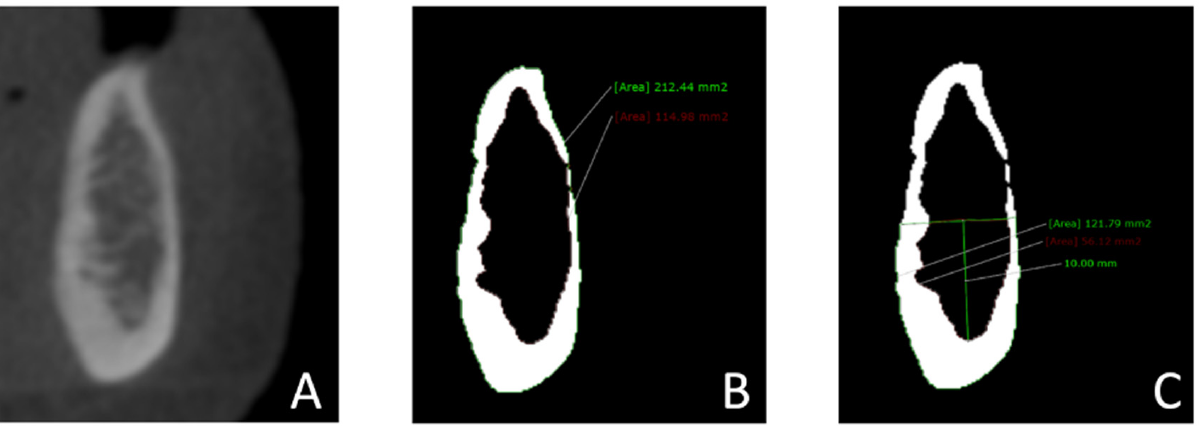
Figure 2. Measurements of the mandibular bone volume in cross-sectional images: ( A ) A cross- sectional slice was obtained in the regions of the lateral incisor, first premolar, and first molar. ( B ) Images were converted to binary images (black and white) to distinguish cortical bone from trabecular bone by adjusting the window’s level (960 gray values) and width (0 gray values). The total bone volume and trabecular bone volume in the complete mandible were measured. ( C ) The total bone volume and the trabecular bone volume in the basal part of the mandibular body were measured. The basal part of the mandibular body was defined as the entire mandibular area measuring 10 mm in height, starting at the most caudal point of the cortical–trabecular bone border and extending in the coronal direction.